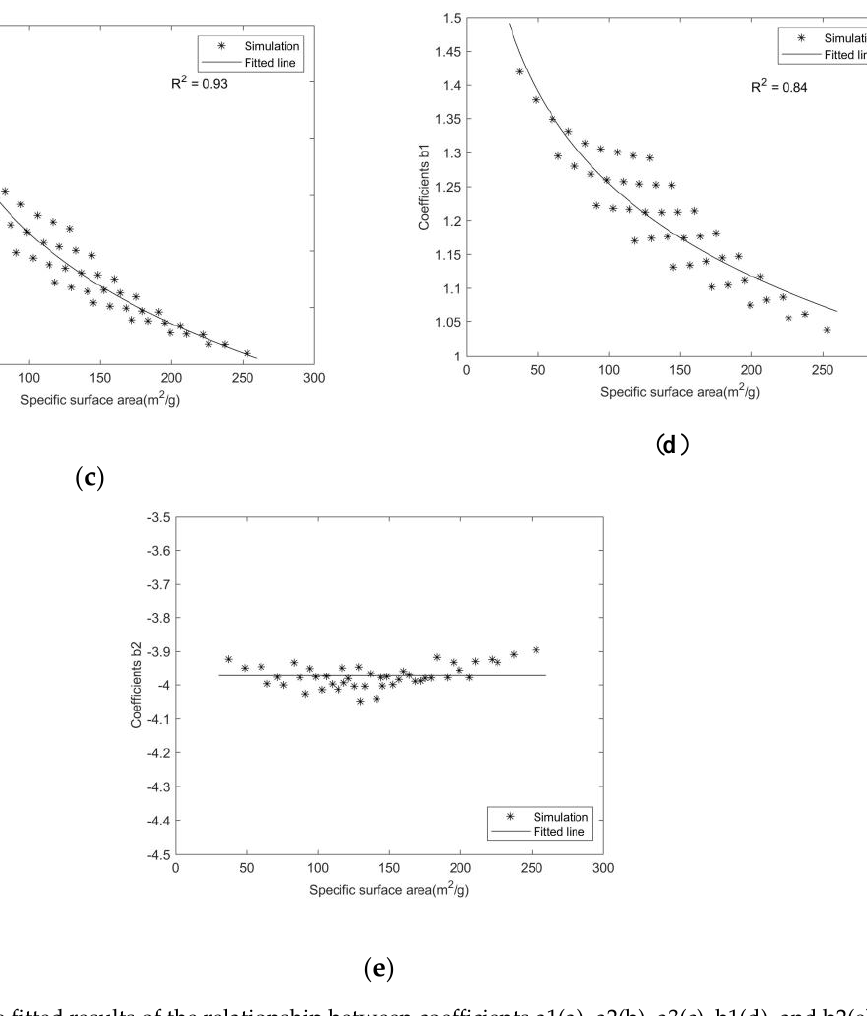
Figure 7. The fitted results of the relationship between coefficients a1(a), a2(b), a3(c), b1(d), and b2(e) and specific surface area.